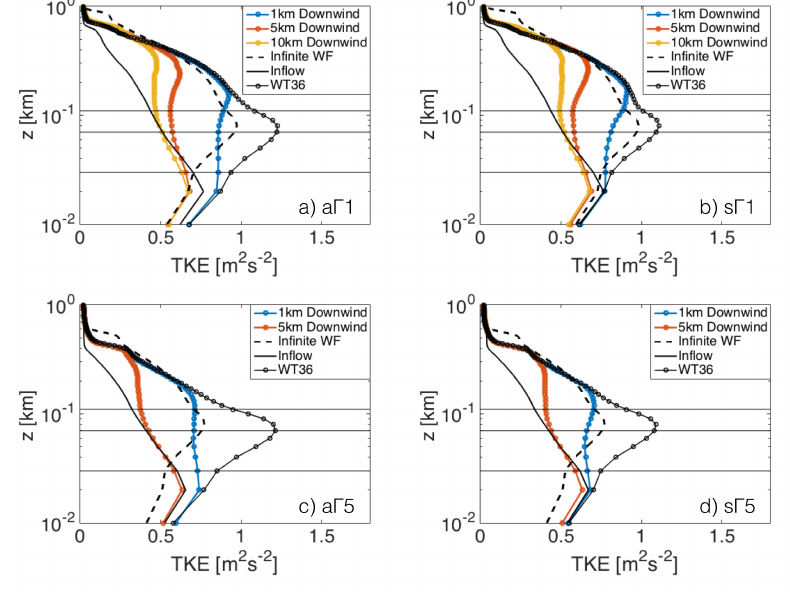
Figure 13. Vertical profiles of time- and spanwise-averaged TKE at 1 km, 5 km and 10 km downwind of the wind farm, and at the 36th (last) turbine row for the cases: ( a ) FS-a Γ 1; ( b ) FS-s Γ 1; ( c ) FS-a Γ 5; and ( d ) FS-s Γ 5. The solid black profile represents the TKE of the ABL inflow, and the black dashed profile represents the time- and horizontal-averaged total shear stress of the infinite wind farm with the same turbine configuration. The black horizontal solid lines represent the top-tip, hub and bottom-tip